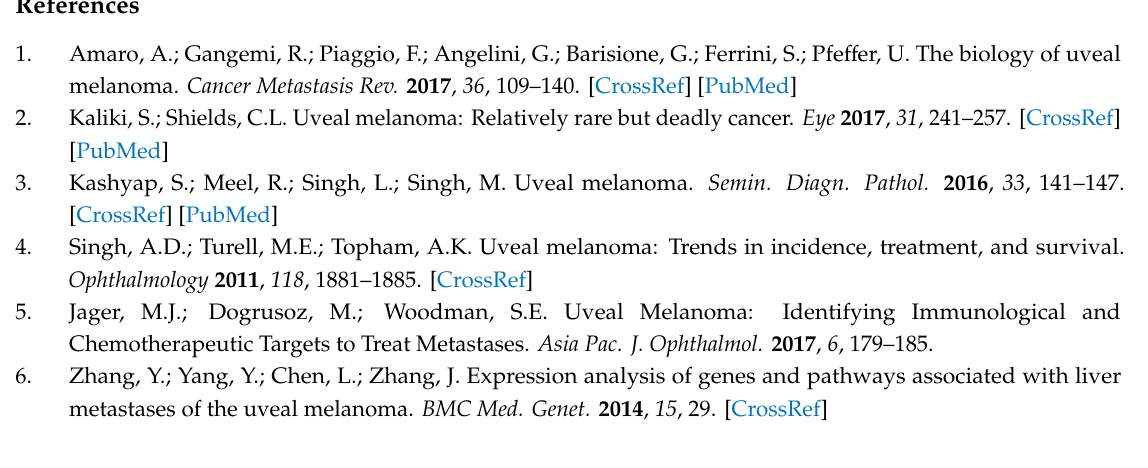
Figure S1: The accuracy curve with the number of genes and the performance of classifiers. The x-axis was the number of genes used for SVM classifier construction and the y-axis was the accuracy of the SVM classifier evaluated with Leave one out cross validation (LOOCV). The peak of curve was accuracy of 0.97 when 11 spliced genes were